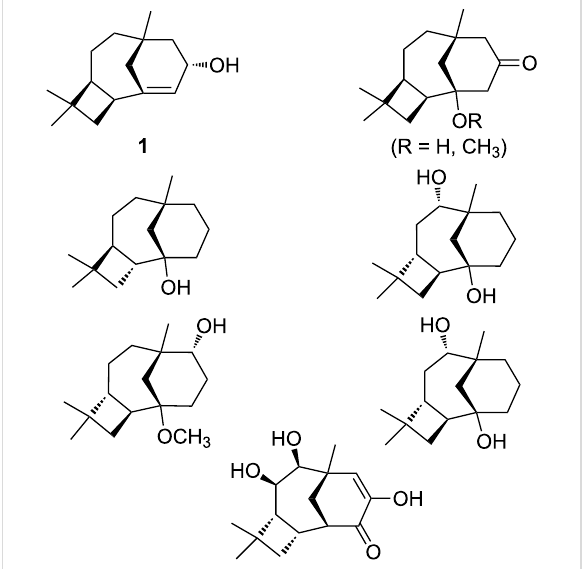
Figure 1: Caryol-1(11)-en-10-ol ( 1 ) and similar sesquiterpenoids. Note that a different atom numbering was used in the paper describing the isolation of 1 [2].